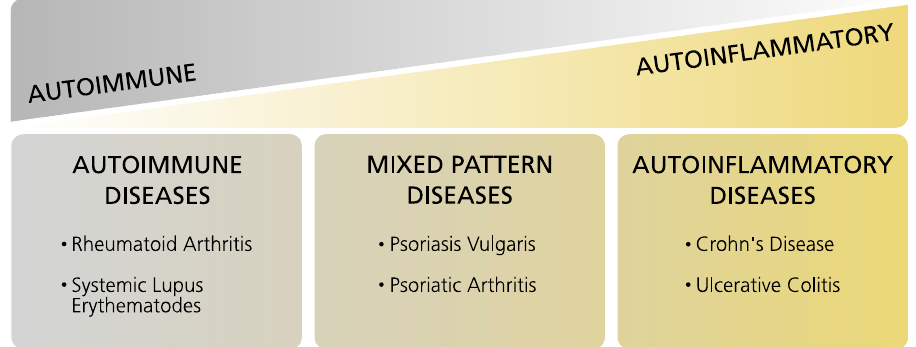
Figure 1. Tabular overview of immune-mediated inflammatory diseases (IMIDs). Adapted from Reference [3].